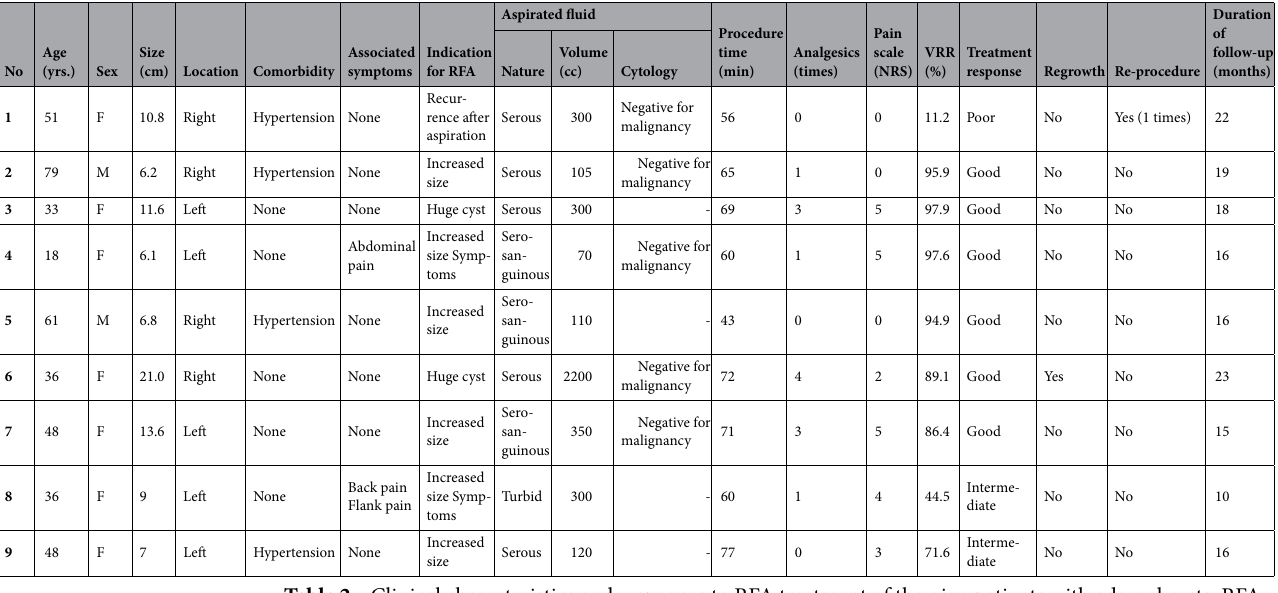
Table 2. Clinical characteristics and responses to RFA treatment of the nine patients with adrenal cysts. RFA, radiofrequency ablation; VRR, volume reduction rate; NRS, numerical rating